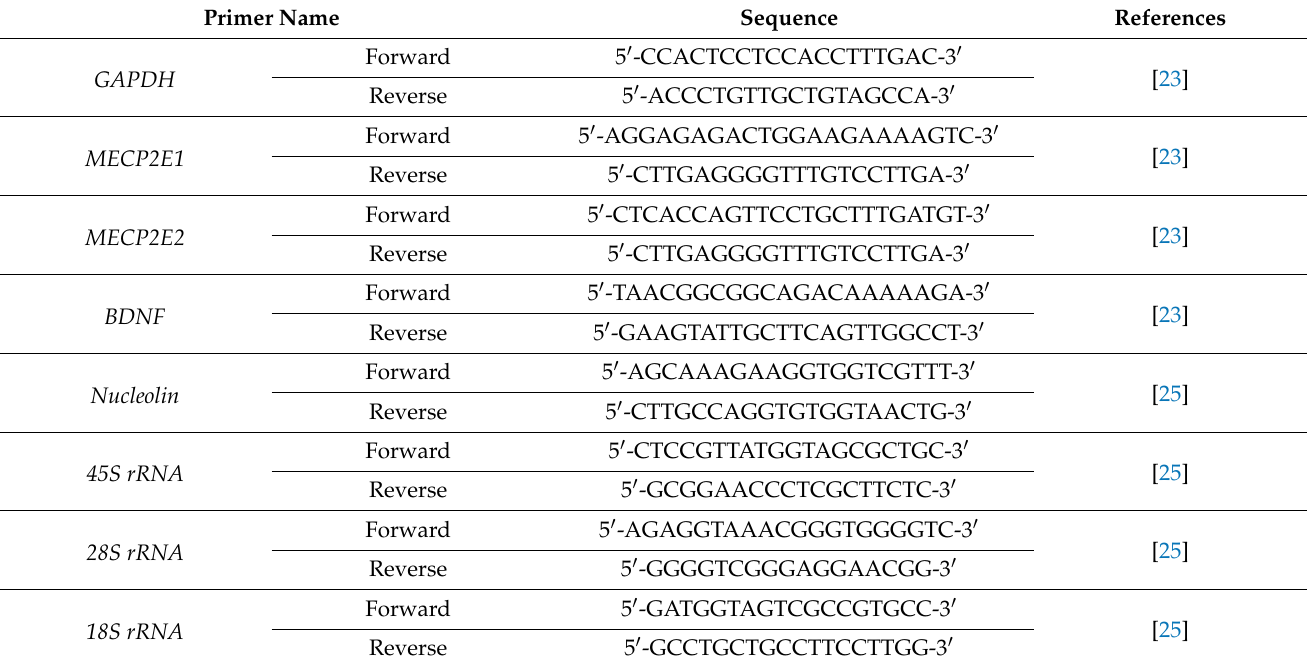
Table 3. Primer Sequences Used for